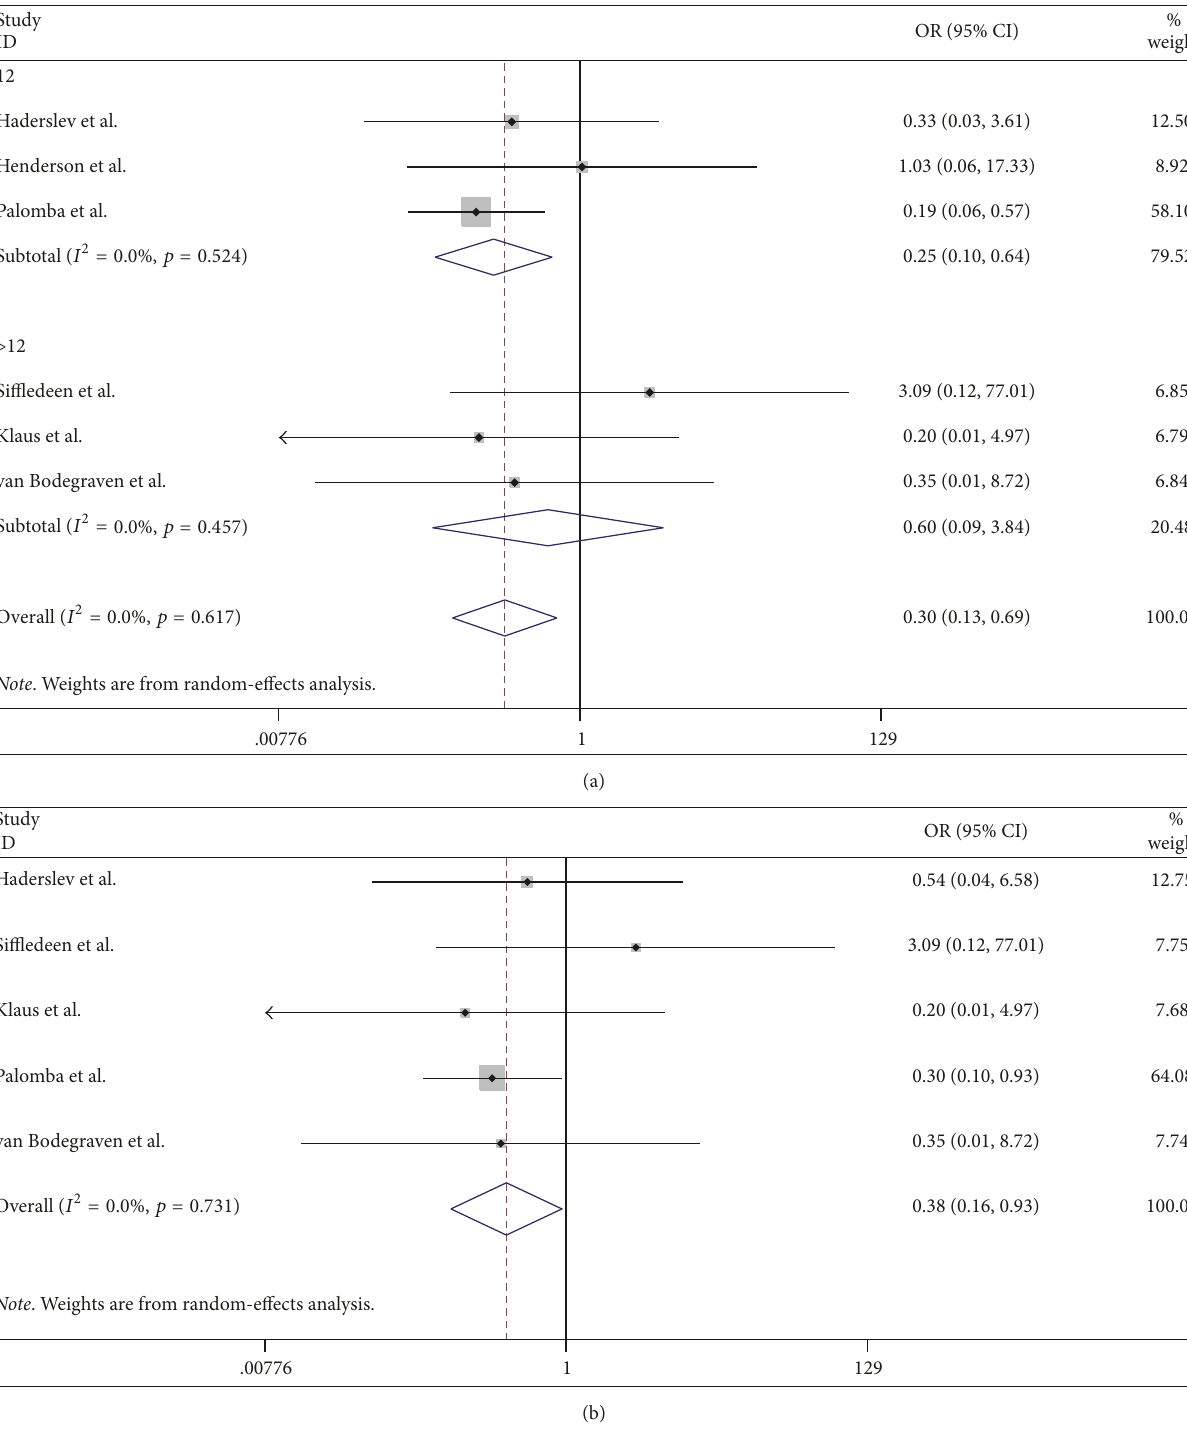
Figure 5: Randomized controlled trials of bisphosphonates in reducing new fractures and vertebrate fractures in IBD. (a) Forest plot showing the odds ratio and 95% confidence interval of the incidence of new fractures of the bisphosphonate and control groups. A subgroup analysis of the treatment duration of the two groups is also shown. (b) Forest plot showing the odds ratio and 95% confidence interval of the incidence of vertebrate fractures of the bisphosphonate and control